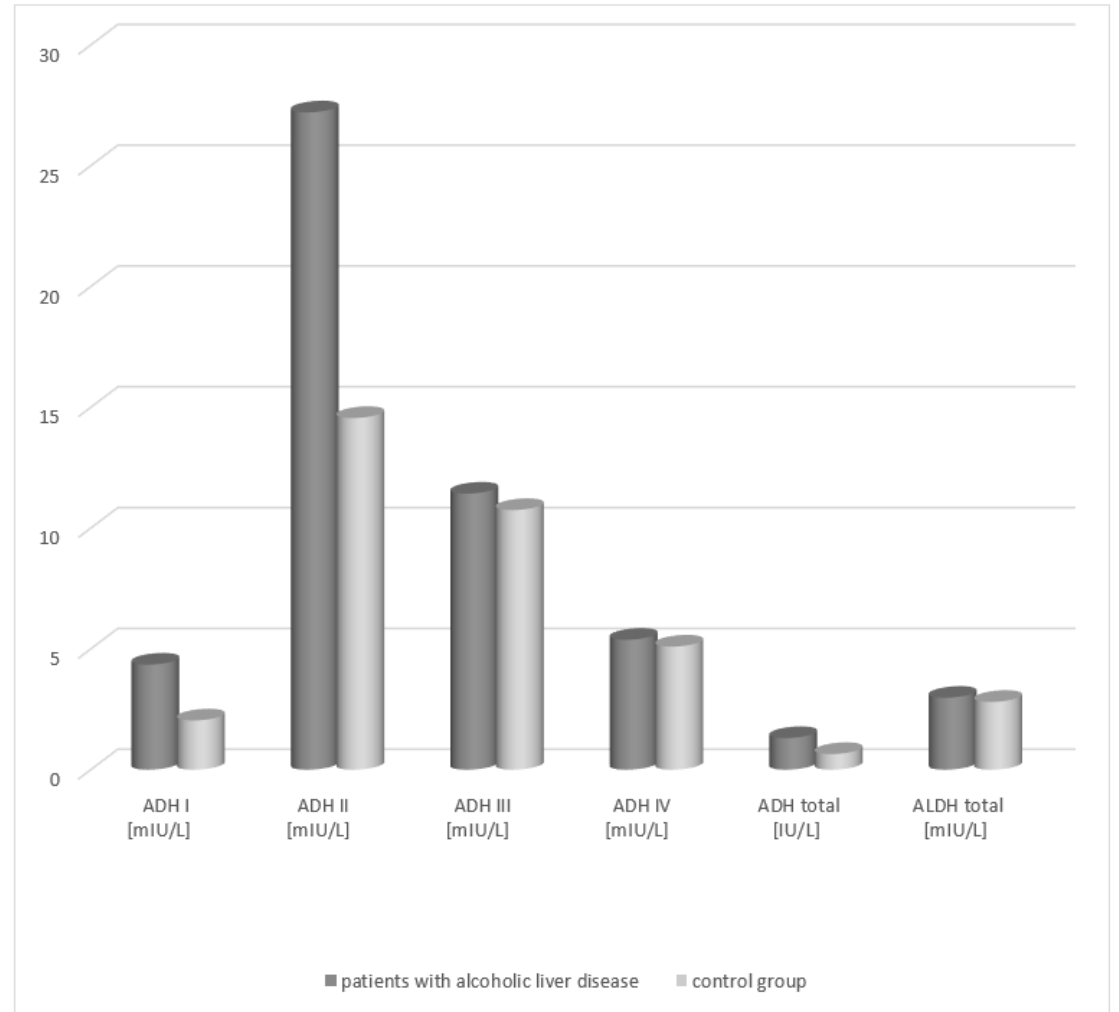
Figure 1. Activity of ADH and ALDH in the serum of patients with alcoholic fatty liver.